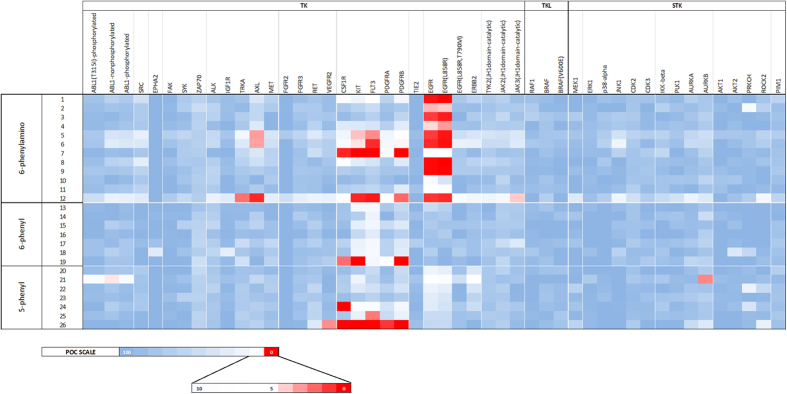
Results of primary screening of compounds against kinases.The heat map displays the results of the primary screening in terms of POC values for each pair of kinase/ligand. The lower the POC (white to red boxes), the tighter the binding. Compounds are listed according to Fig. 2.